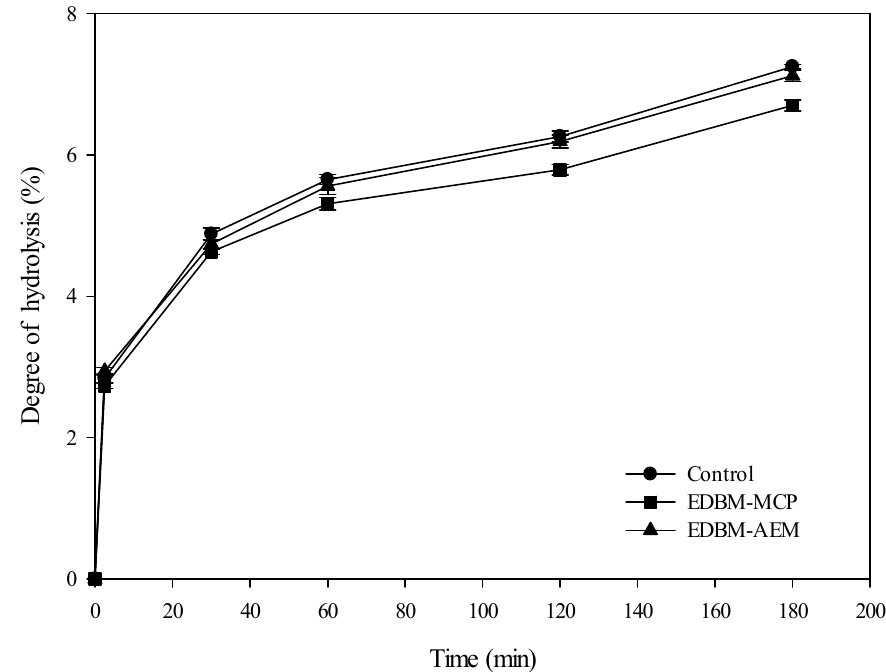
Figure 8. Hydrolysis curves of hemoglobin hydrolysis in control, EDBM-MCP and EDBM-AEM treated with pepsin for 3 h. Hydrolysis was conducted at the following conditions: enzyme (U) / protein (mg) ration of 1 / 11, pH 3 and at 30 °C.